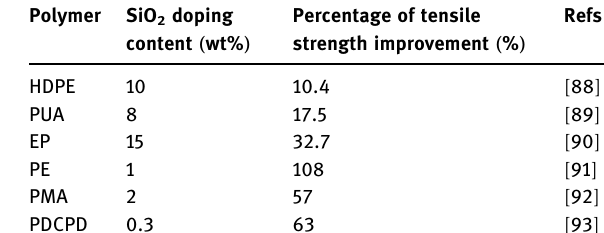
Table 1: Di ff erent tensile strength data as reported Polymer SiO 2